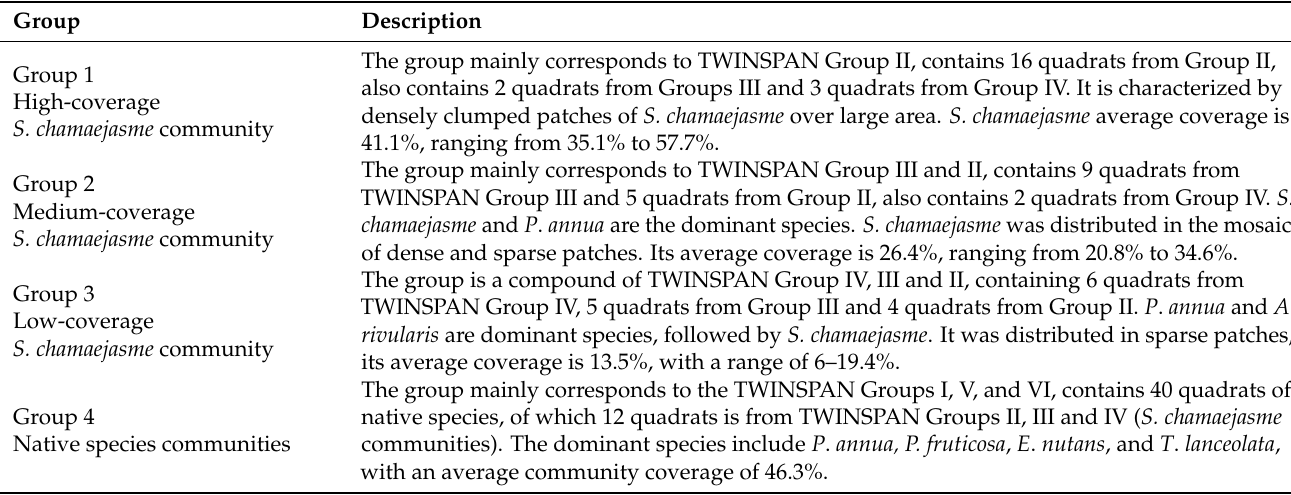
Table 4. Ecological characteristics of TWINSPAN-adjusted classes.